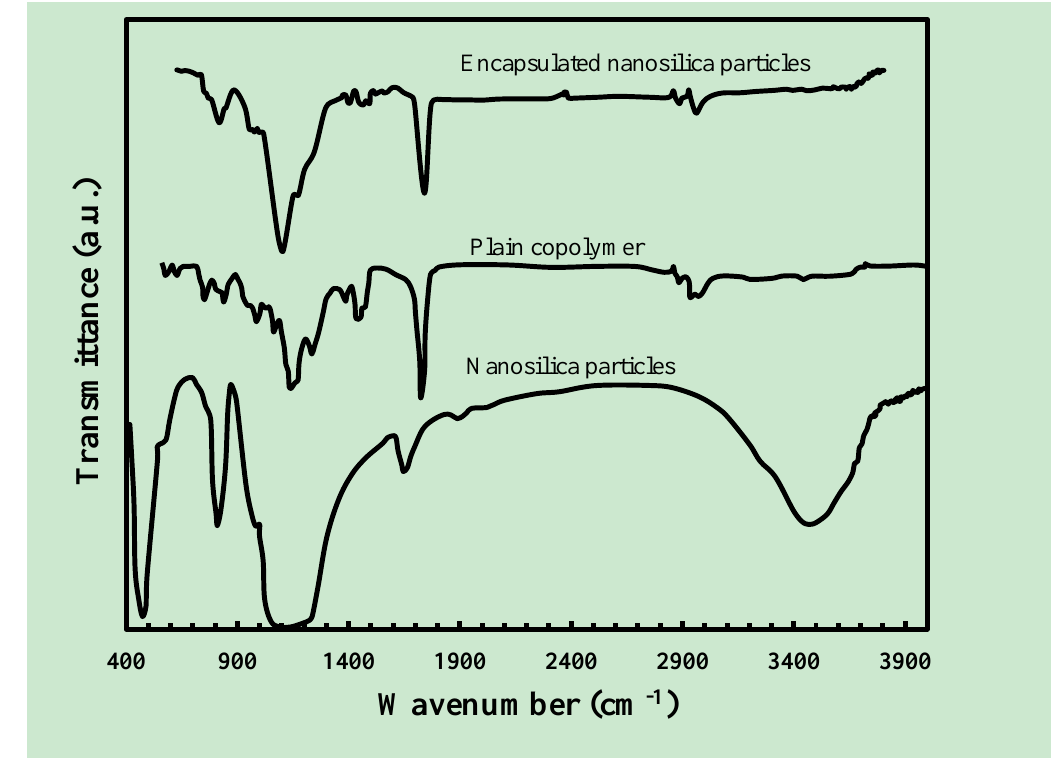
Figure 2. Fourier transform infrared spectroscopy (FTIR) spectra of nanosilica particles, plain copolymer and encapsulated nanosilica particles with the acrylic